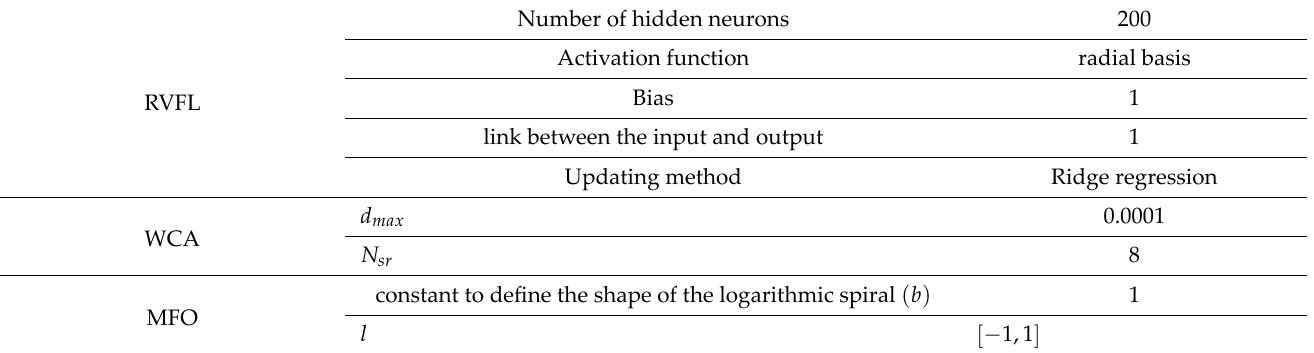
Table 2. Parameters setting of each optimization